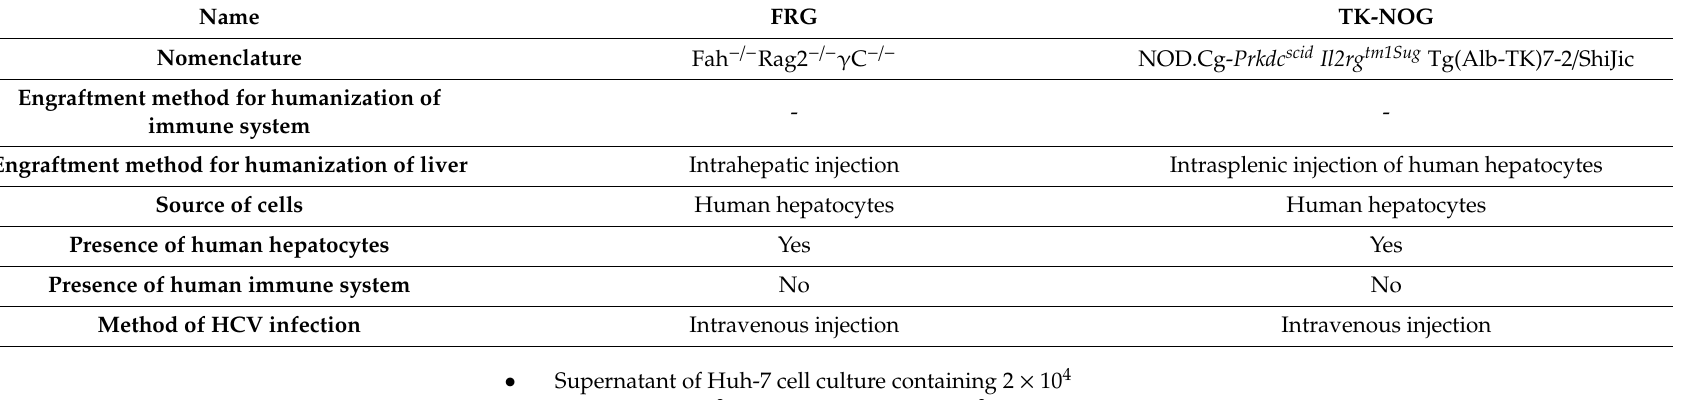
Table 2. Chimeric human liver mouse models (Part